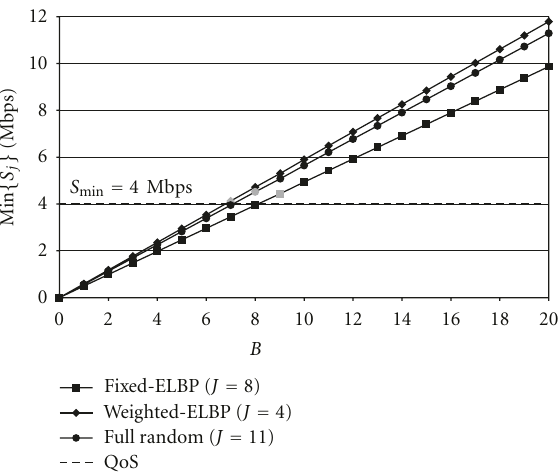
Figure 11: Minimal throughput versus the burst size.